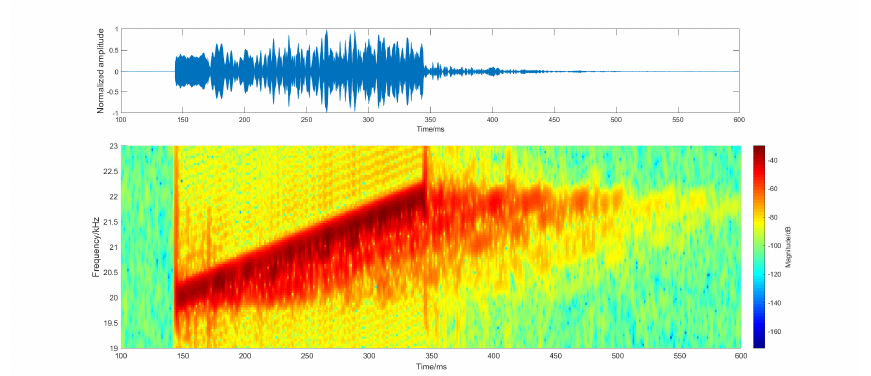
Figure 10. The waveform of received signal with lake experiments data.